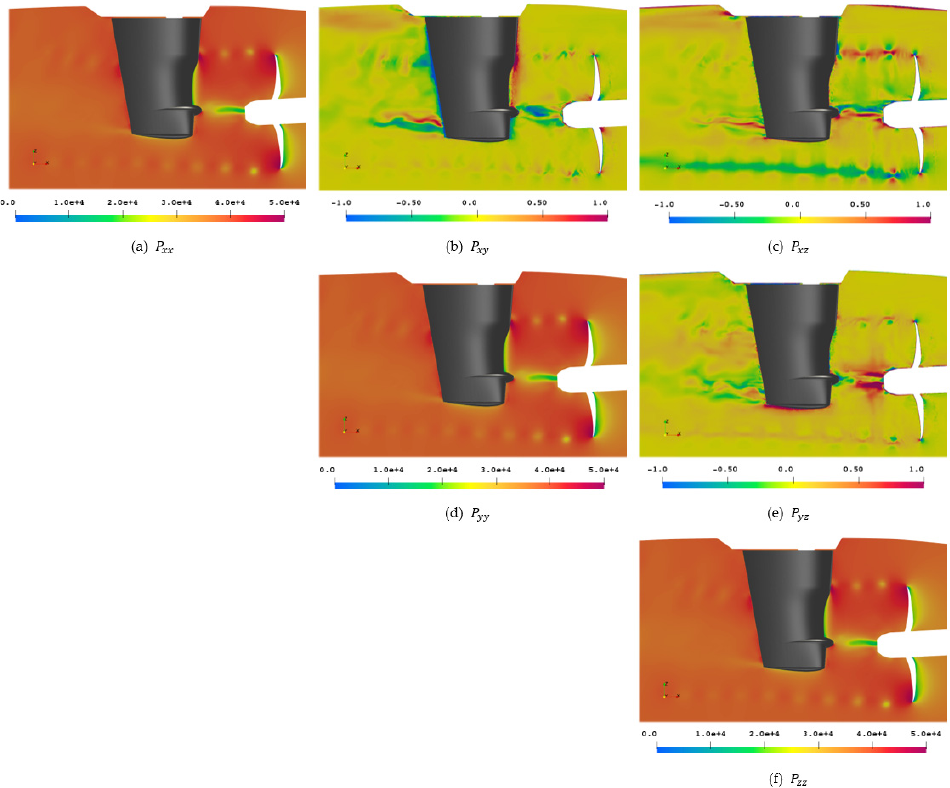
Figure 20. Fluid compressive stress tensor P ij in [ Kg/ms 2 ].